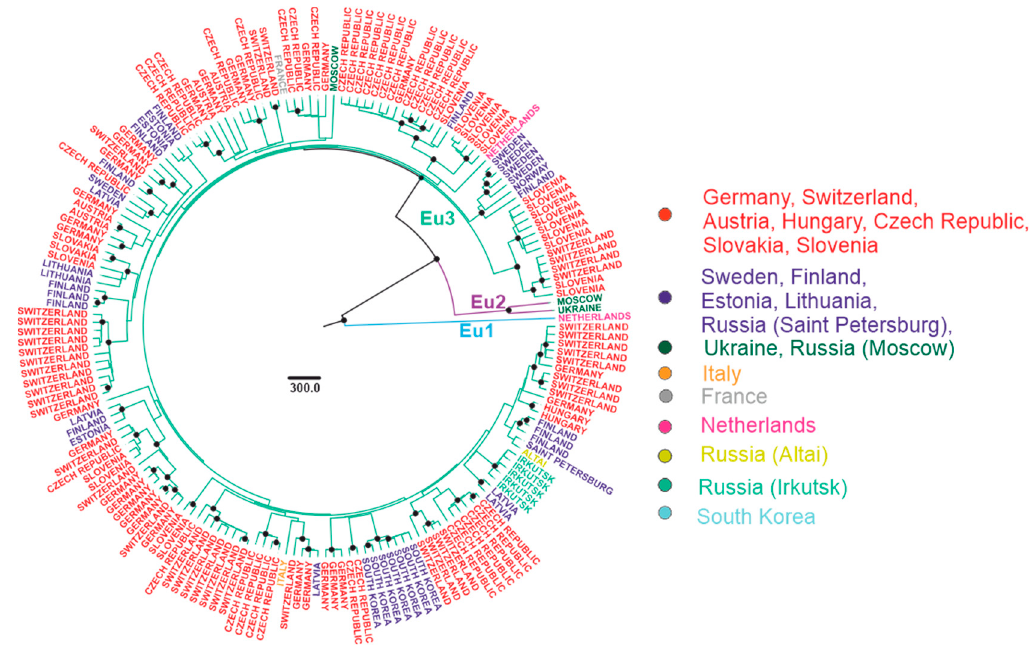
Figure 5. Bayesian phylogenetic analysis of near-complete E-gene sequences of European TBEV. Branches are color-shaded according to described groups. Tree tips are named according to the region of isolation. Countries or country regions of virus sampling were grouped into nine color-coded geographical regions. Node posterior probabilities above 95% are shown by black circles at the relevant nodes.